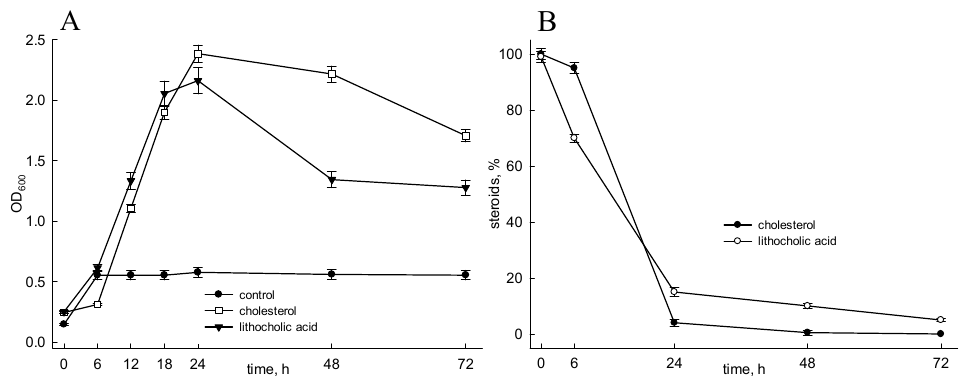
Figure 2. Growth of Nocardioides simplex on cholesterol or LCA and consumption of substances. ( A ) Growth of N. simplex on cholesterol or LCA. ( B ) Consumption of cholesterol, or LCA during N. simplex growth. Mineral medium supplemented with MCD was used in the control. Cholesterol, or LCA were added to the medium as per (2.3). Steroids were assayed by TLC as per (2.6). The data are the average of triplicates.